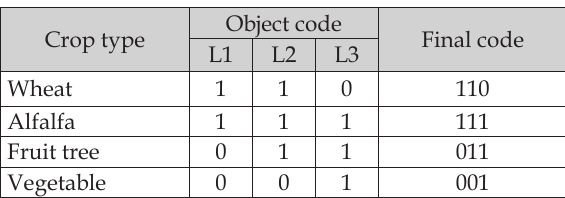
Table 1. The classification scheme is used to recognise crop